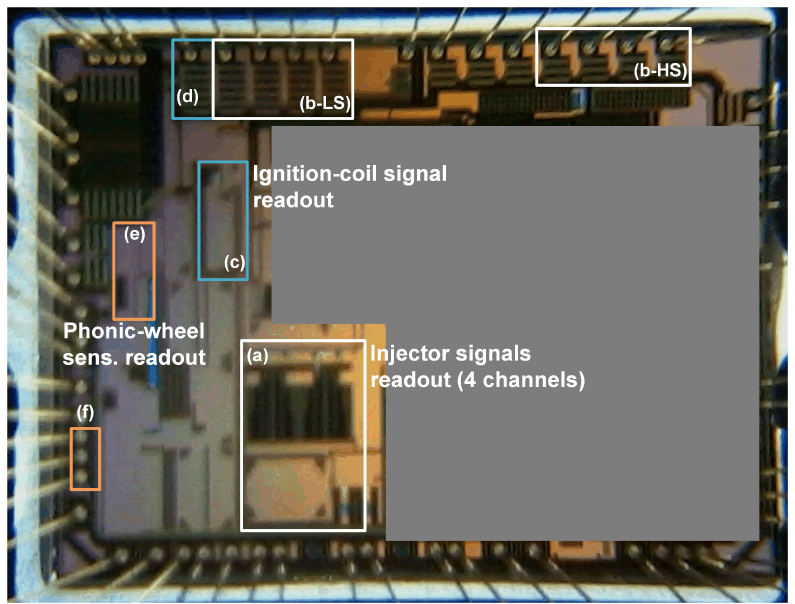
Figure 12. Chip photograph. White boxes: four-channel interface and readout circuit for high and low-side injector signals ( a ) with ESD protections and ( b ) pads (b-LS and b-HS). Blue boxes: interface and readout for ignition-coil signal ( c ) with ESD protection and pad ( d ). Orange boxes: interface and readout for phonic-wheel inductive sensor ( e ) with ESD protections and pads ( f